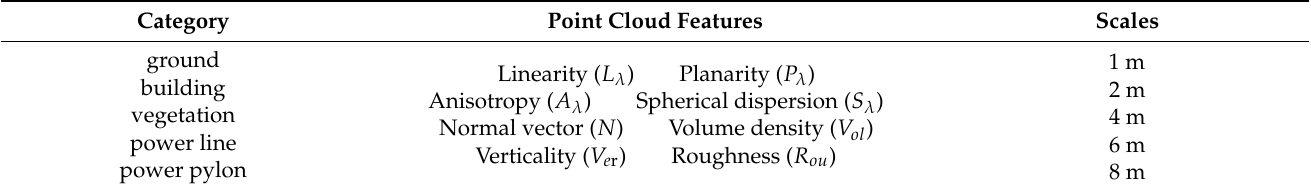
Table 1. The geometric features used in classification of point clouds for transmission line corridor. Category Point Cloud Features Scales ground Linearity ( L λ ) mbuilding vegetation power line power